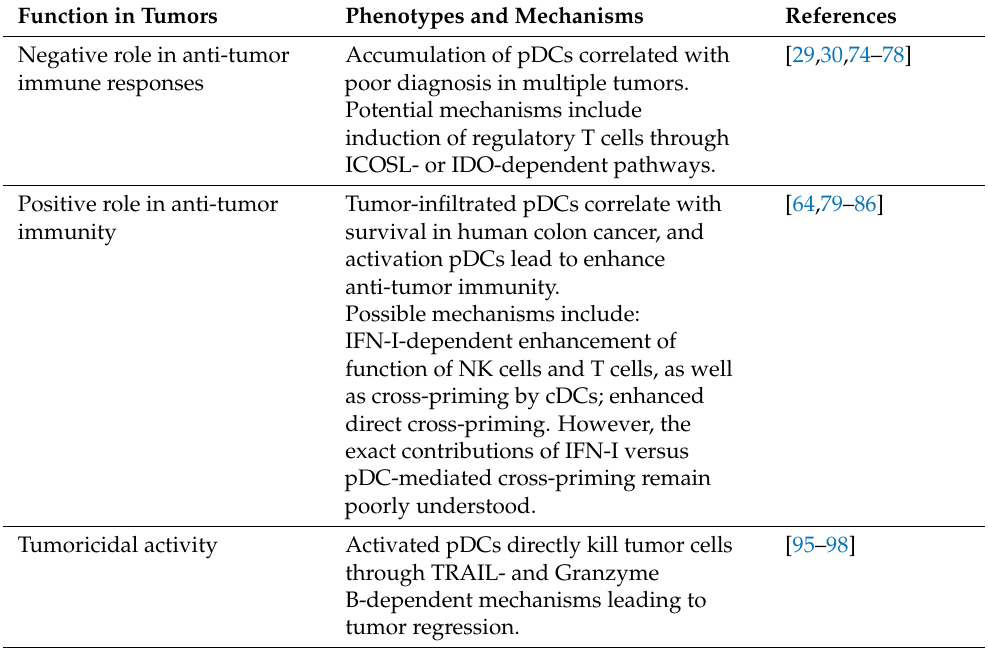
Table 1. Opposite functions of pDCs in